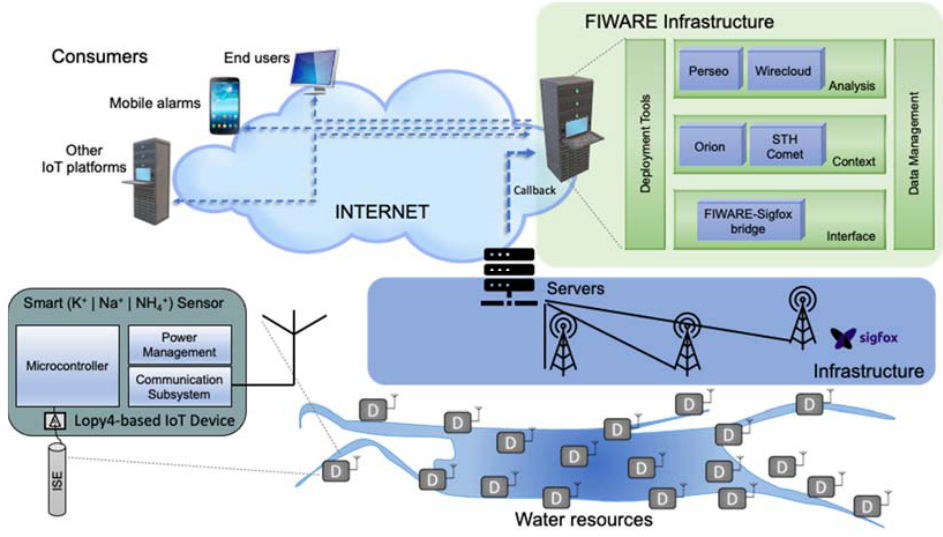
Figure 2. Potassium monitoring system.